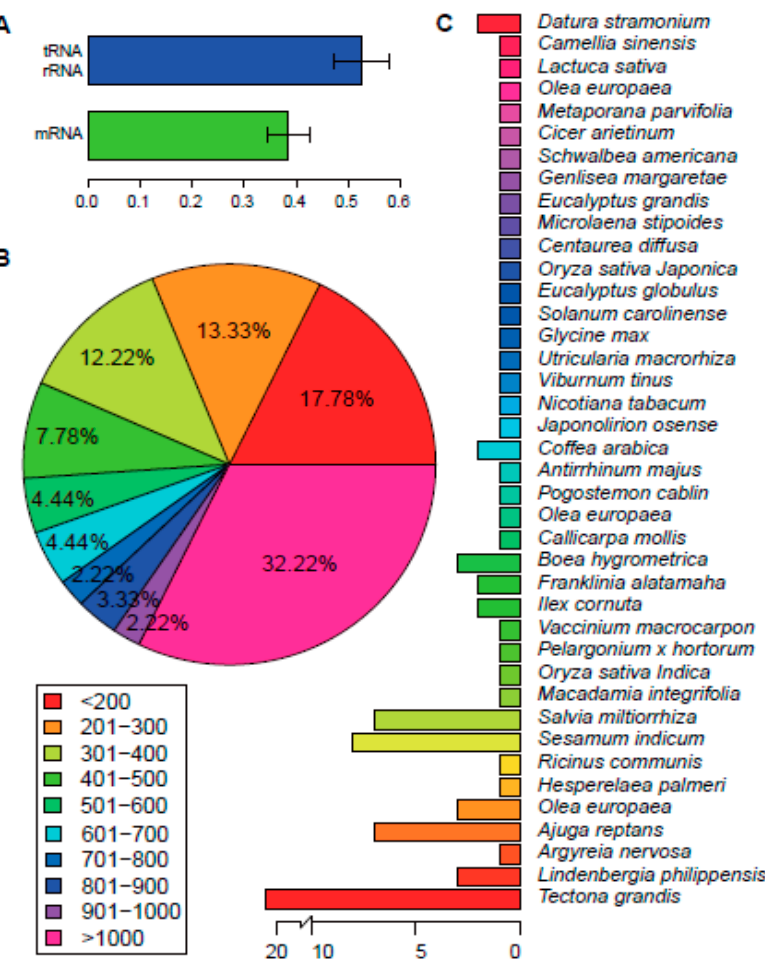
Figure 1. Genome Annotation. ( A ) GC content of protein-coding genes and tRNA/rRNA genes; ( B ) the length distribution of protein-coding genes; ( C ) the number of best hits for P. cablin chloroplast protein-coding genes among species.